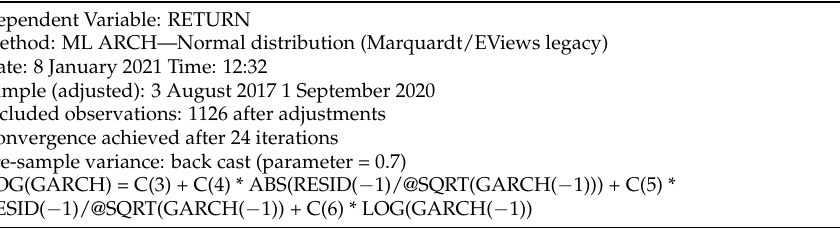
Table 6. Estimated Result of E-GARCH Model for Brazilian Real Return Index during